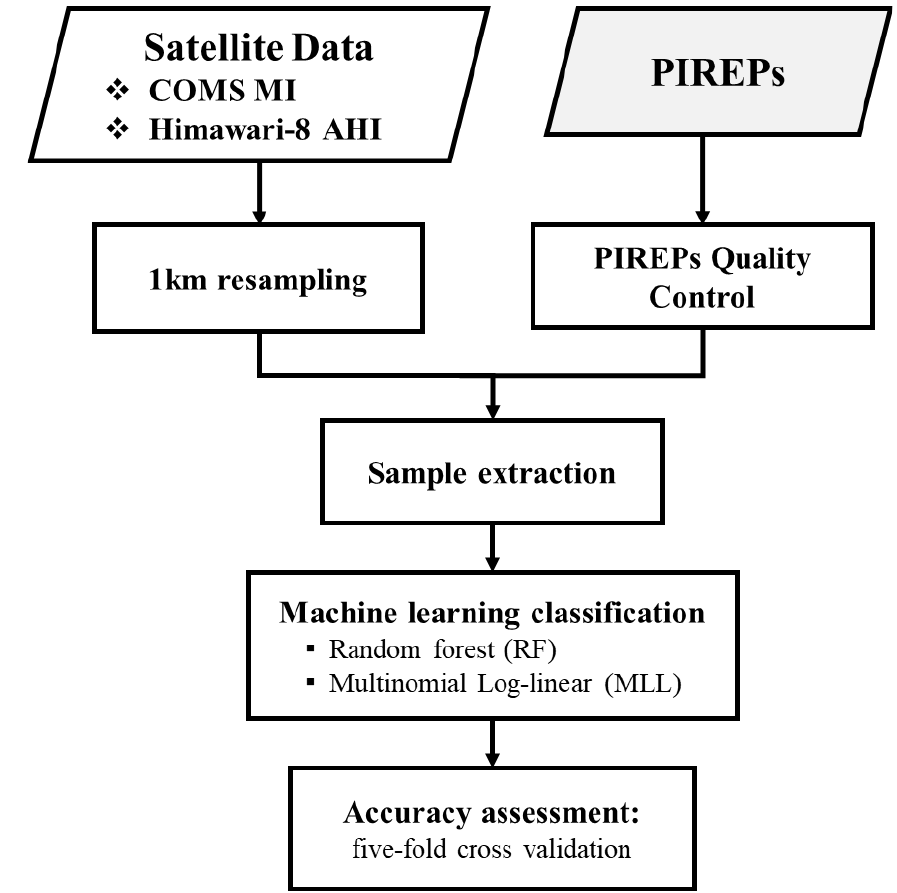
Figure 1. A flow chart of the proposed machine-learning-based icing detection approach.